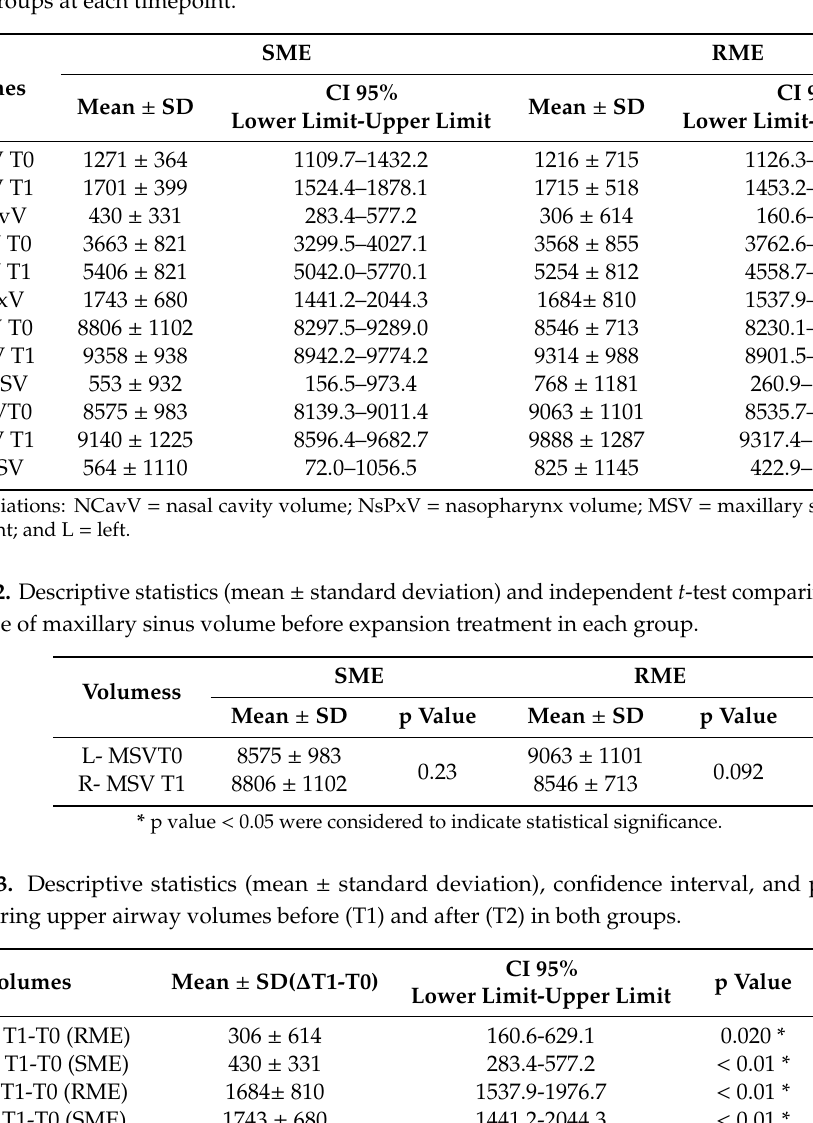
Table 1. Descriptive statistics: Mean value ± standard deviation (SD) and confidence interval (CI) for both groups at each timepoint.